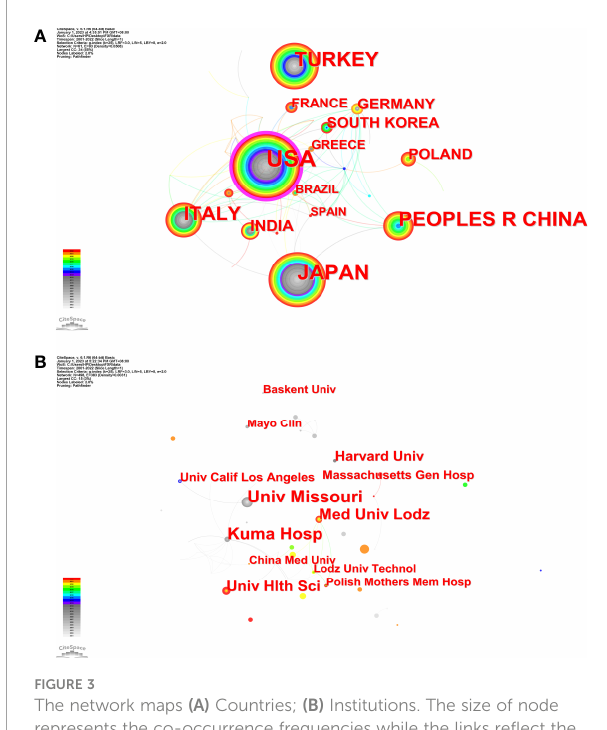
FIGURE 3 The network maps (A) Countries; (B) Institutions. The size of node represents the co-occurrence frequencies while the links re fl ect the co-occurrence relationships. The color of node and line indicates different